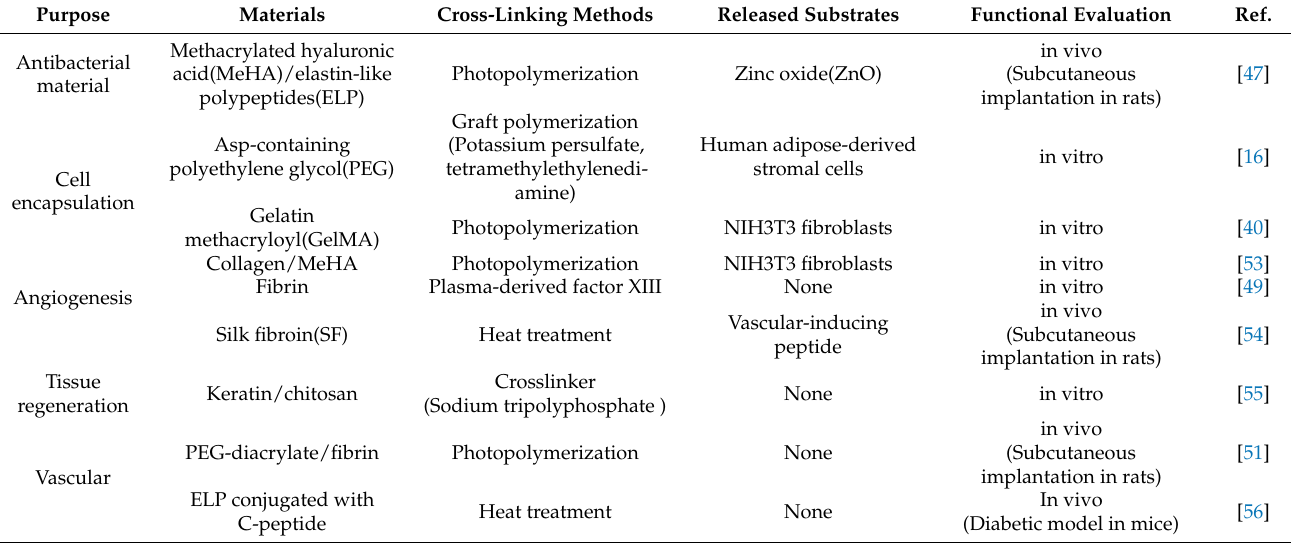
Table 1. Natural polymer-based